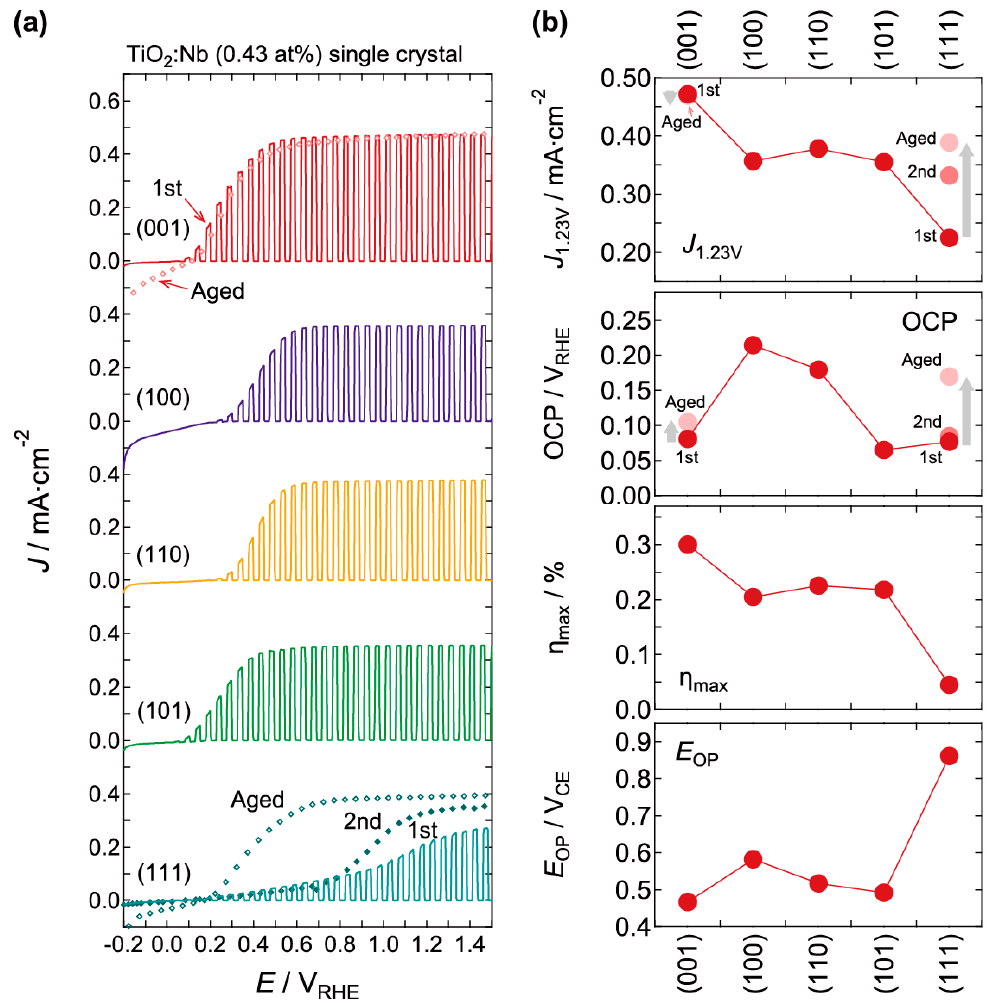
Figure 5. ( a ) The LSV curves for the TiO 2 :Nb(001), (100), (110), (101), and (111) single-crystal substrates. The “1st” and “2nd” simply represent the frequency of LSV measurement for the fresh substrate. The data which do not show the annotation mean measurements for the fresh substrates. The “aged” represent the sample after the PEC reaction at 1.5 V RHE for 30 min. ( b ) The surface plane dependence of TiO 2 :Nb substrates on J at 1.23 V RHE ( J 1.23V ), OCP, η max , and e ff ective bias potential for the η max ( E OP